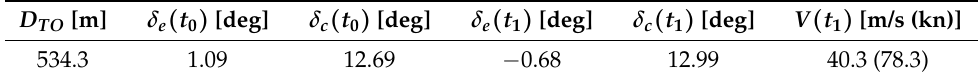
Table 5. Parameters for optimal take-off for a three-surface aircraft.